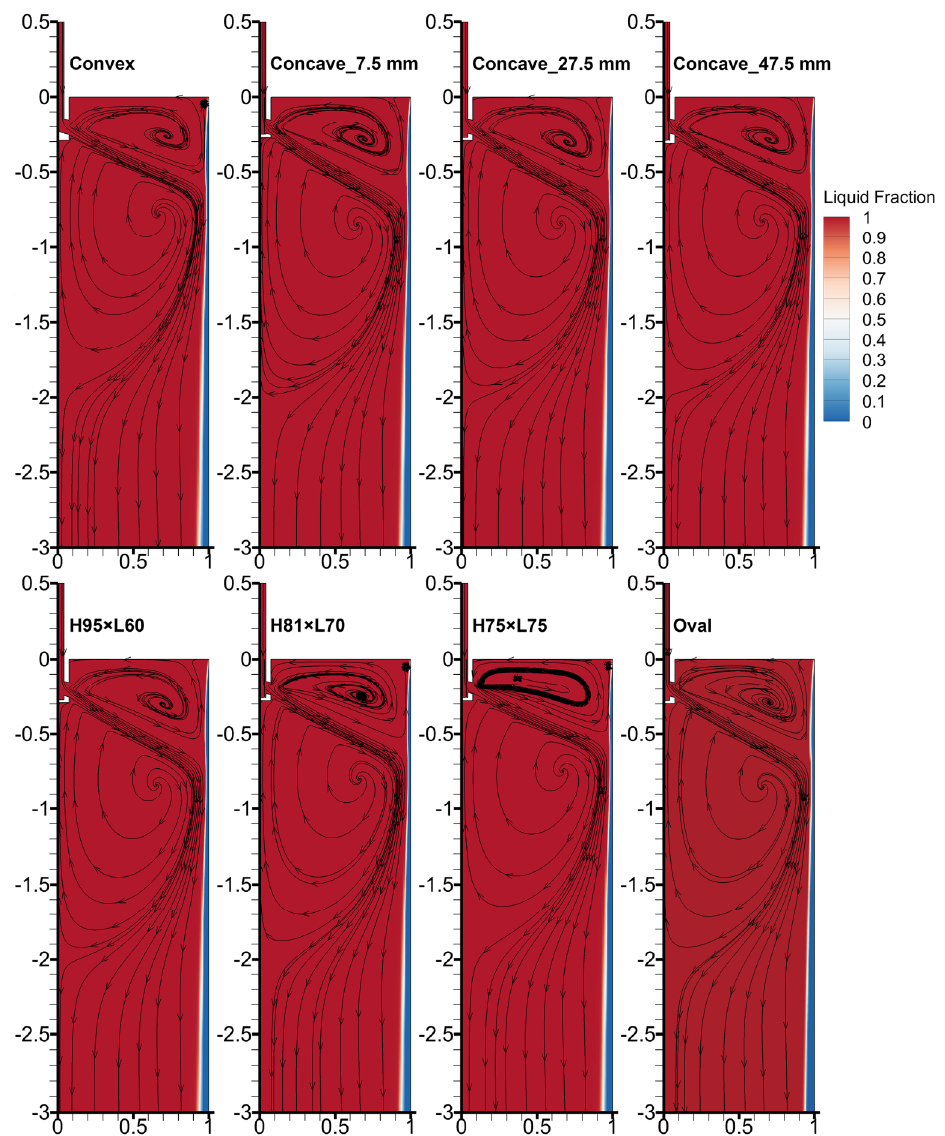
Figure 3. Streamline and contour plot of steel liquid fraction on the mid-thickness plane of the mold with different SEN bottoms and port shapes.